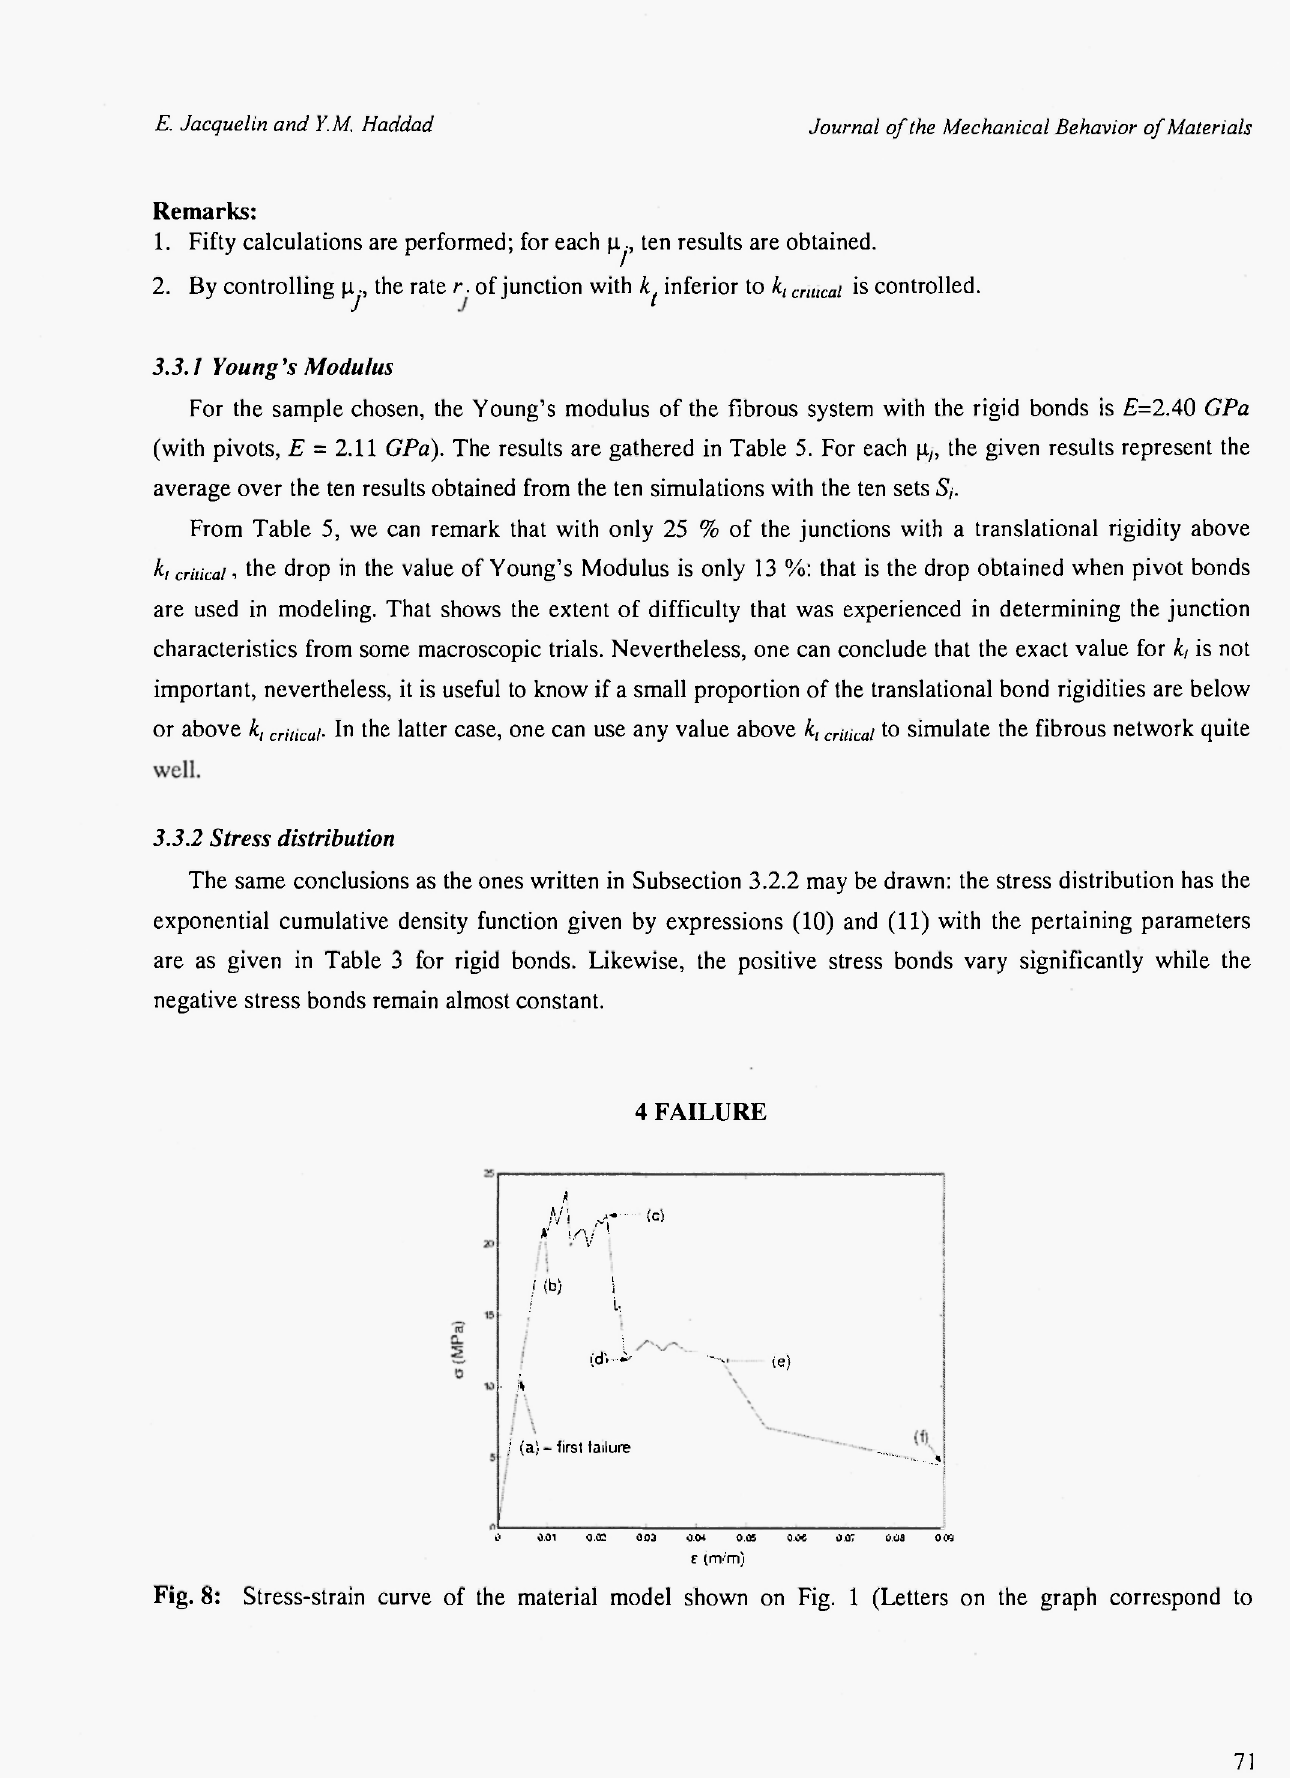
Fig. 8: Stress-strain curve of the material model shown on Fig. 1 (Letters on the graph correspond